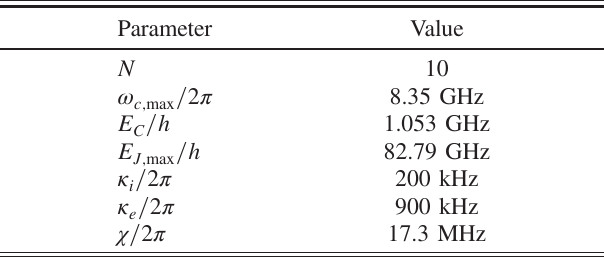
TABLE I. Device parameters for the Kerr parametric oscillator.